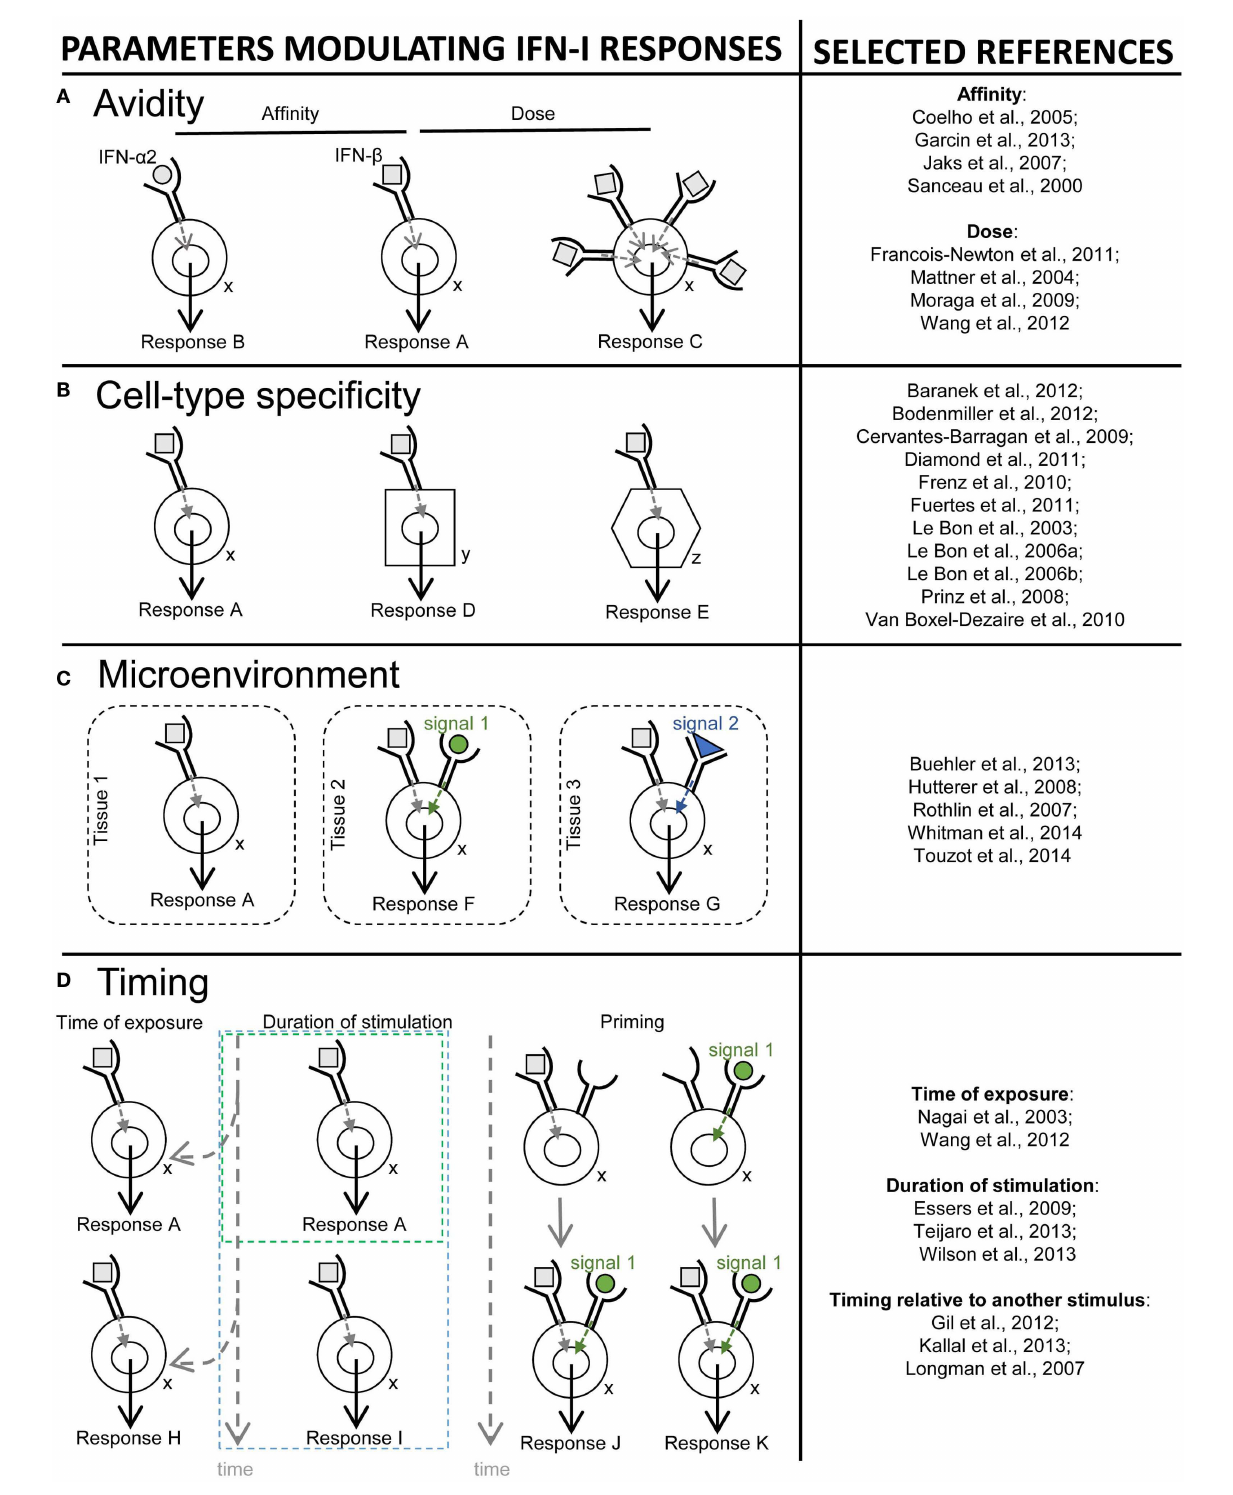
FIGURE 9 | Schematic illustration of different mechanisms controlling the diversity of IFN-I effects . Different parameters that contribute to promote and control the diversity of IFN-I responses are depicted on the left side of the figure. References of papers illustrating each mechanism are given